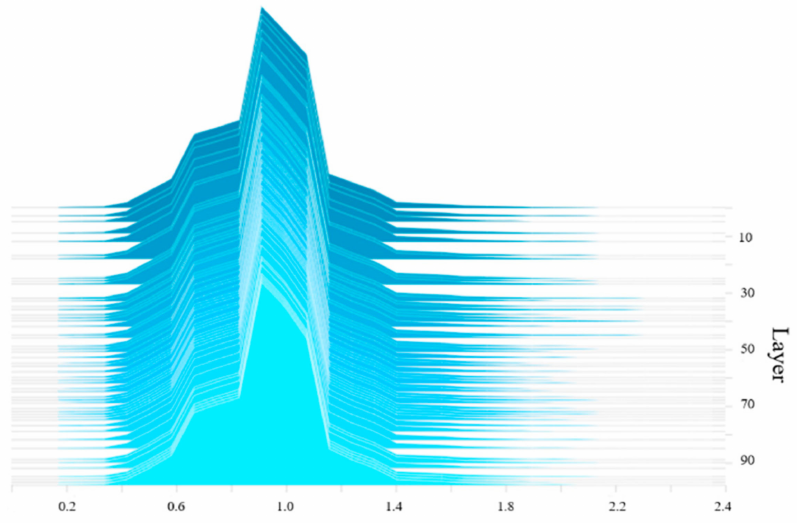
Figure 5. BN layer γ value distribution before the sparse